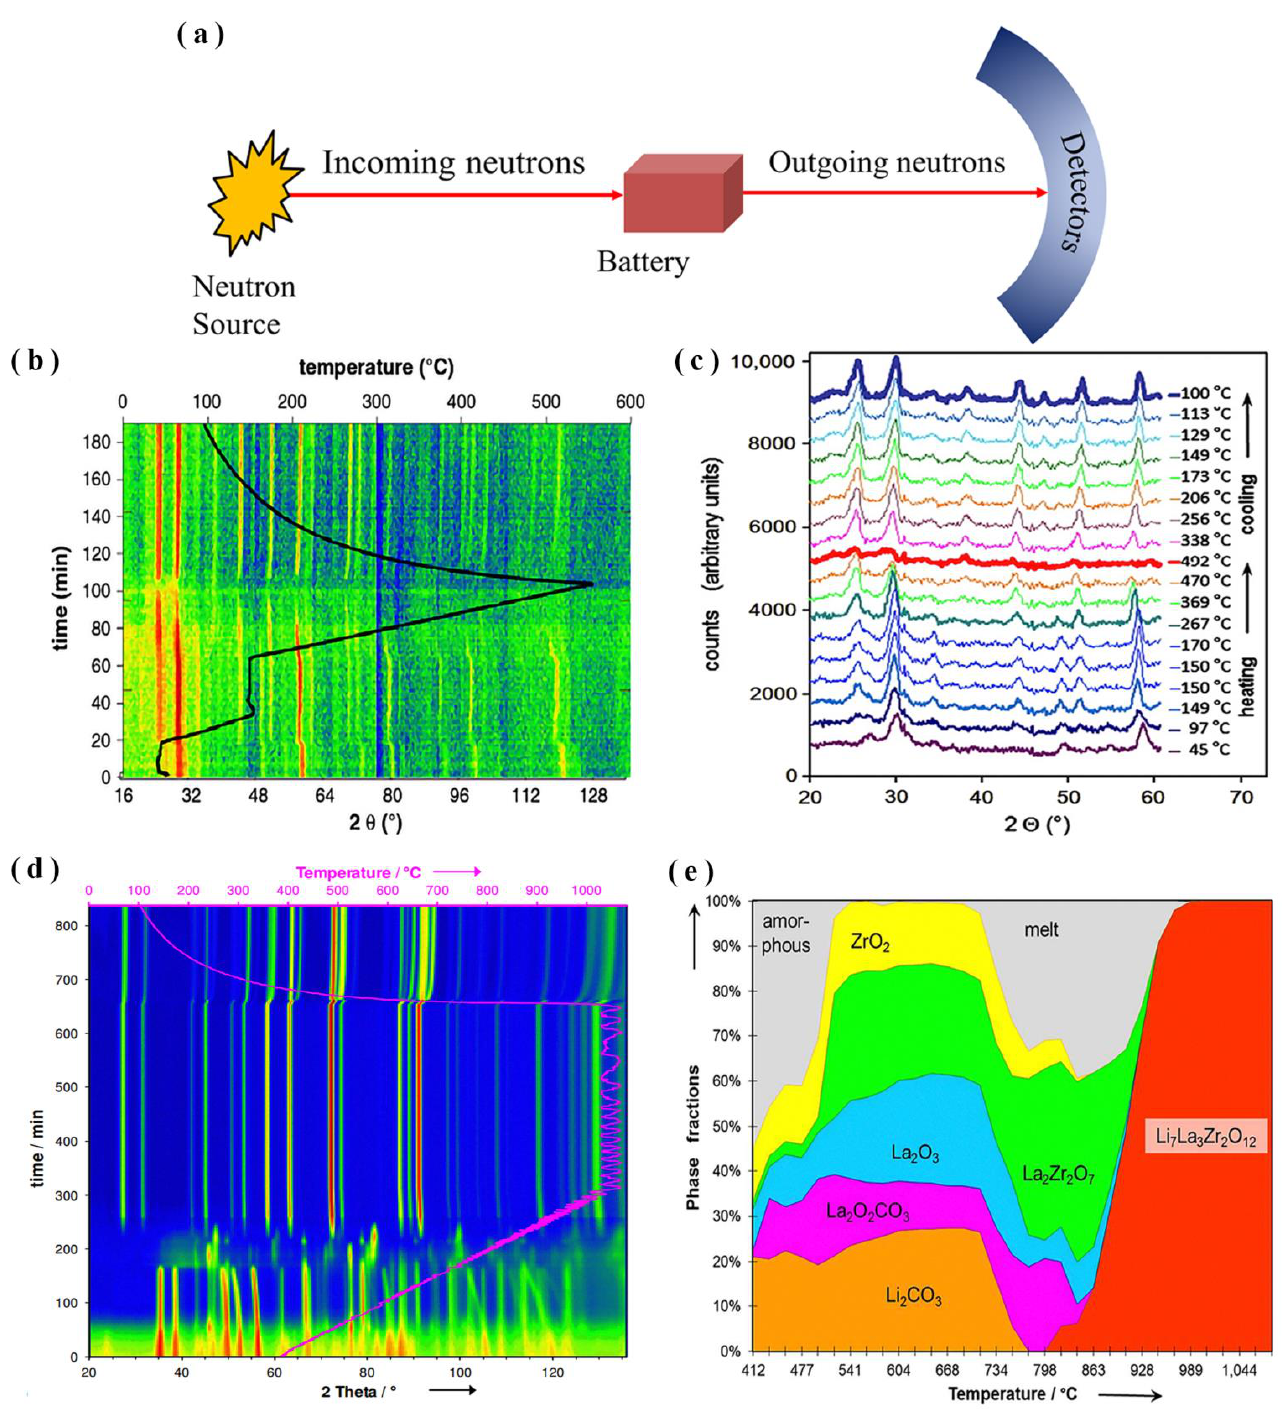
Figure 2. ( a ) Simplified diagram for in situ / Operando NPD measurements. ( b ) Patterns of Li 6 PS 5 Cl SSE diffraction in two dimensions (2D), ( c ) NPD patterns for Li 6 PS 5 Cl SSE at various temperatures (adapted with permission from Ref. [27]. 2013 Elsevier B.V). ( d ) 2D of LLZO formation diffraction pattern intensity contour map, ( e ) Rietveld analysis weight fractions of LLZO sample phases during heating (adapted with permission from Ref. [32]. 2015 American Chemical